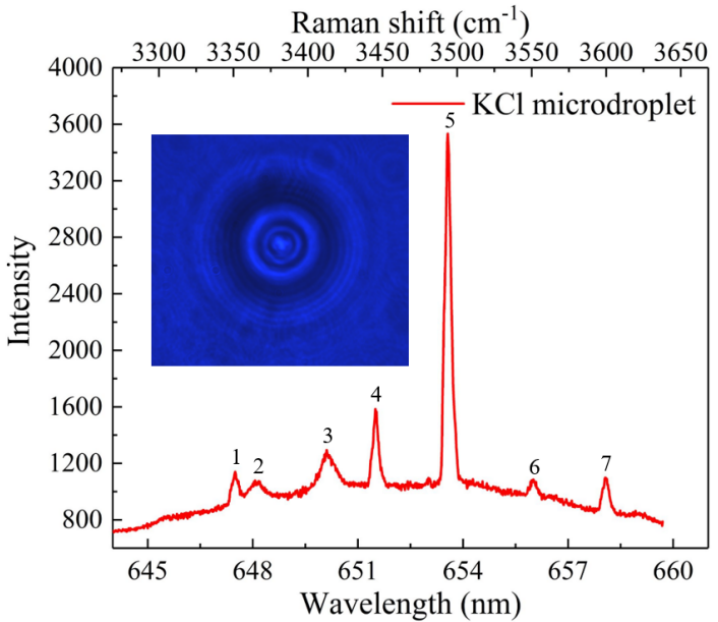
Figure 2. Representative morphology of a KCl microdroplet trapped by the optical tweezers (OTs) and the corresponding Raman spectroscopy signal.